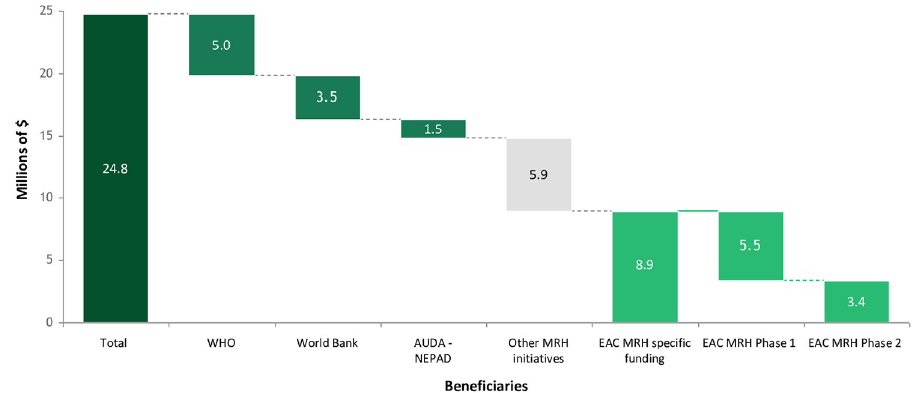
Fig 4. Breakdown of donor funding for the EAC MRH initiative, 2012–2017. EAC MRH Phase 1 lasted from July 2012 through July 2017, and Phase 2, which partially overlapped with Phase 1, lasted from July 2016 through December 2017. Light green represents EAC MRH–specific funding, medium green represents funding for partners, gray represents funding for other MRH initiatives (such as those in the Economic Community of West African States, South African Development Community, and Intergovernmental Authority on Development regions), and dark green represents total funding for the initiative. AMRH, African Medicines Regulatory Harmonization; AUDA-NEPAD, African Union Development Agency–New Partnership for Africa’s Development; EAC MRH, East African Community’s Medicines Regulatory Harmonization; WHO, World Health Organization.